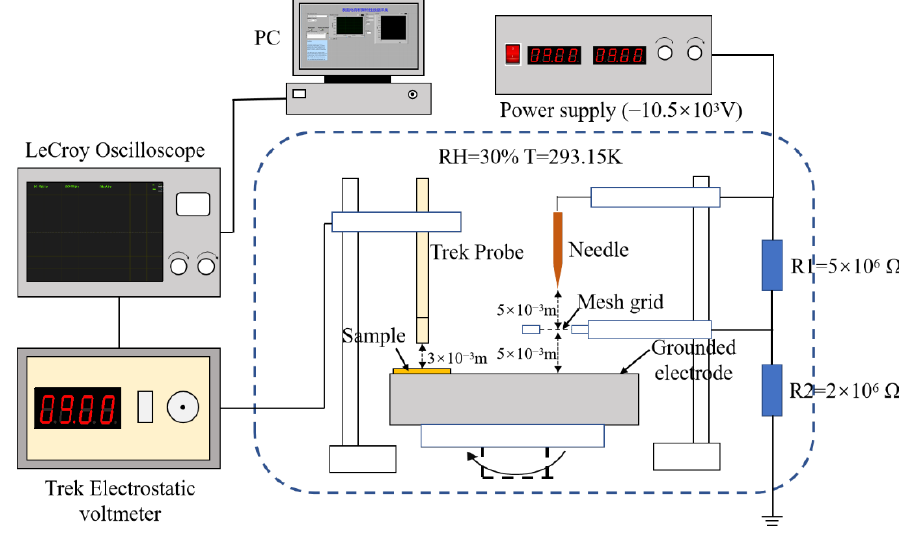
Figure 2. Structure of ISPD experimental equipment.